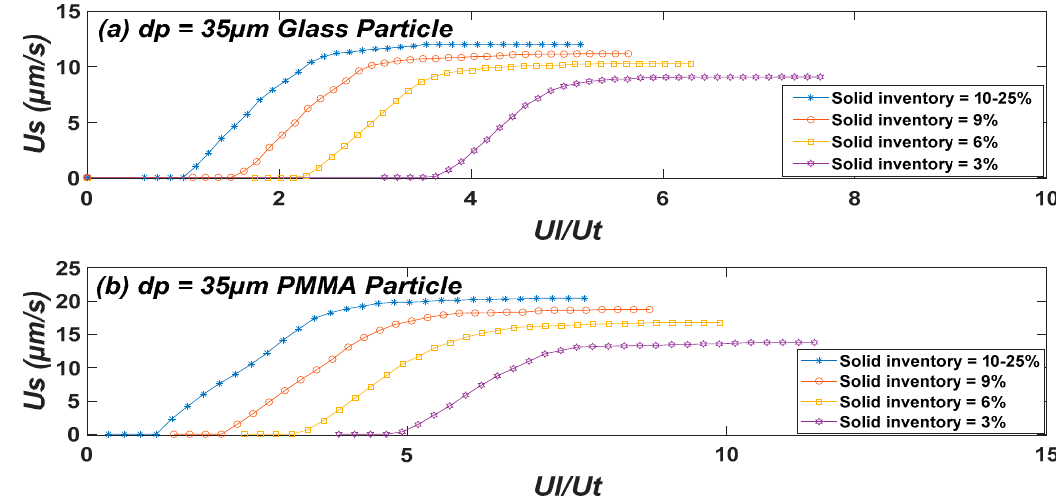
Figure 10. Influence of solid inventory on the particle circulating velocity as a function of normalised velocity ( U l / U t ) for ( a ) glass and ( b ) PMMA particles.